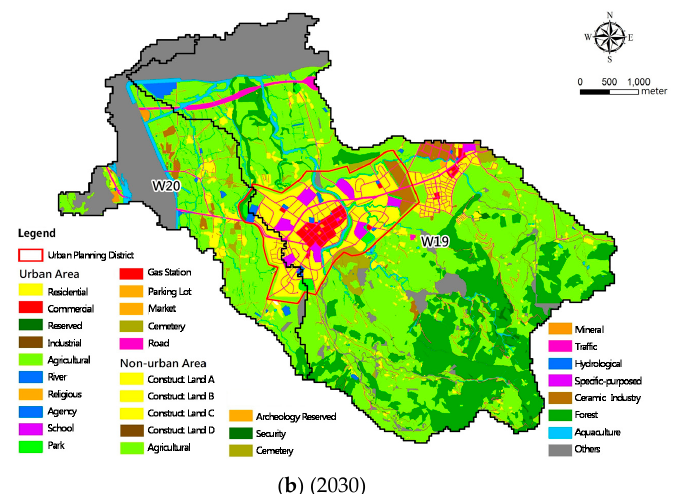
Figure 3. Present and future land-use maps on watershed scale: ( a ) present; ( b ) future.